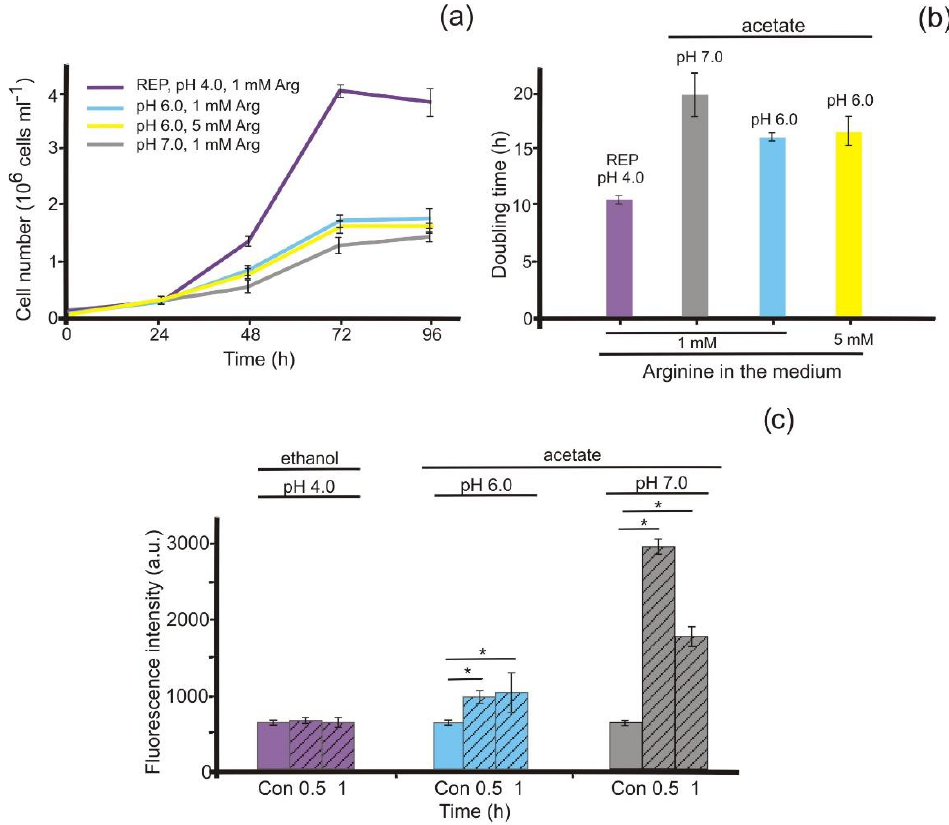
Figure 1. Effects of arginine on cell growth and NO production. ( a ) The growth curves were analyzed in the presence of 1 mM arginine in ethanol-containing medium at pH 4.0 (REP) or in acetate- containing media at pH 6.0 or pH 7.0. Data are presented as the mean ± SE of three independent experiments; ( b ) Doubling times calculated from the experiments shown in ( a ); ( c ) Fluorescence intensity due to intracellular NO was determined using DAF-FM DA and is expressed as arbitrary units per 10 6 cells. Cell autofluorescence was subtracted from the total fluorescence obtained. Cells were grown in REP or acetate-containing media ( a ) and transferred to the respective medium with 1 mM arginine as a nitrogen source for 0.5 h or 1 h (shaded bars). * denotes significant differences between the control (Con) and test variants according to the Student’s t test ( p value < 0.01).